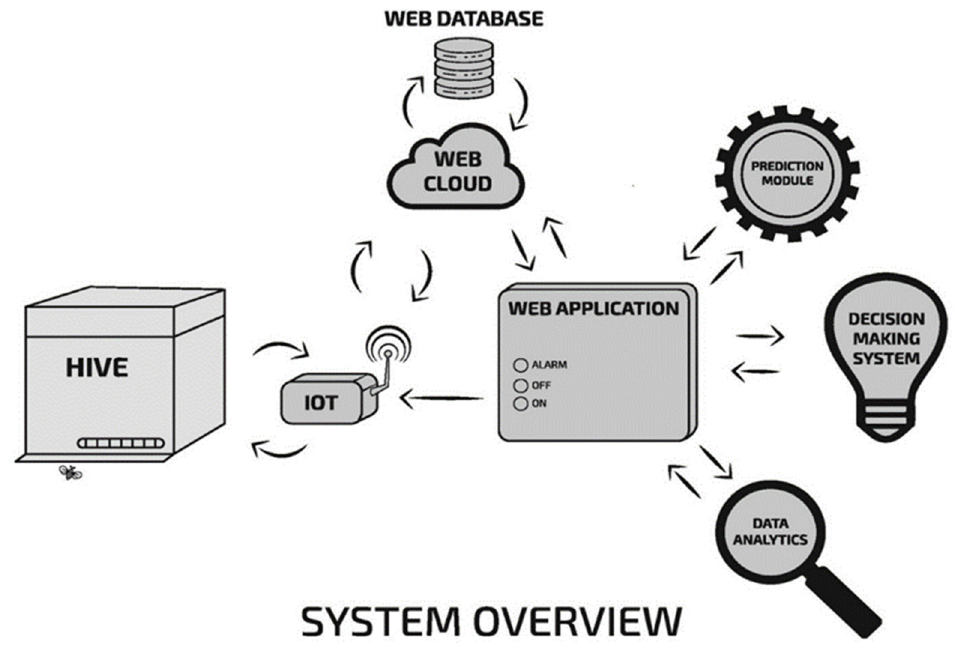
Figure 1. System overview.